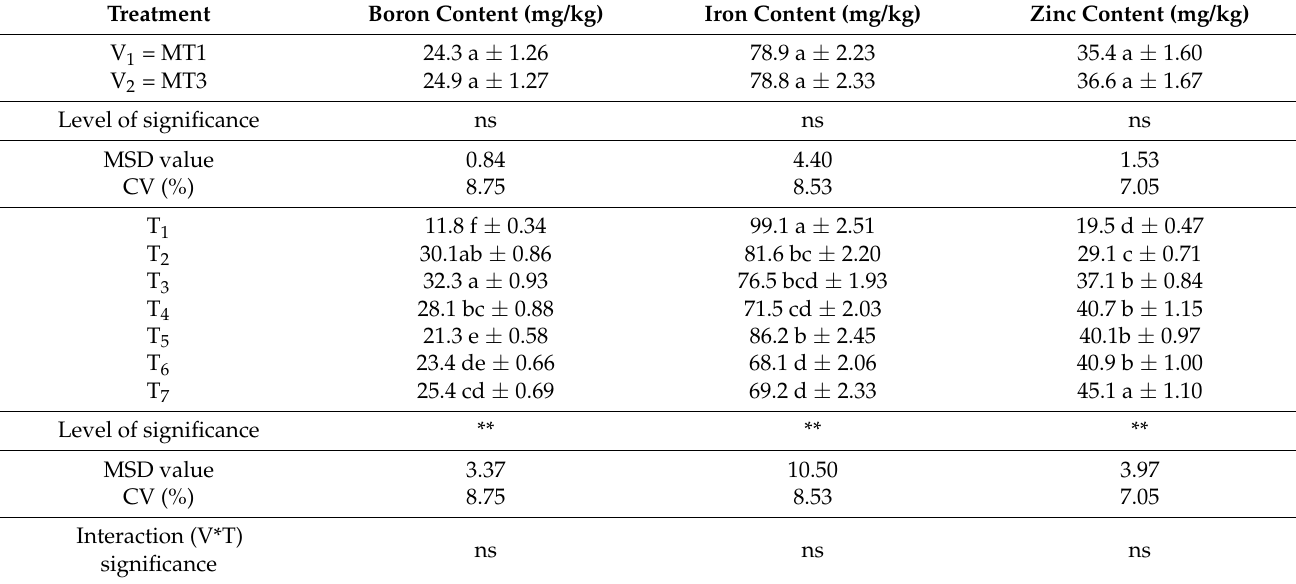
Table 10. Effect of zinc fertilizer and zinc oxide nanoparticles on boron, iron, and zinc content in fruits of two selected tomatoes